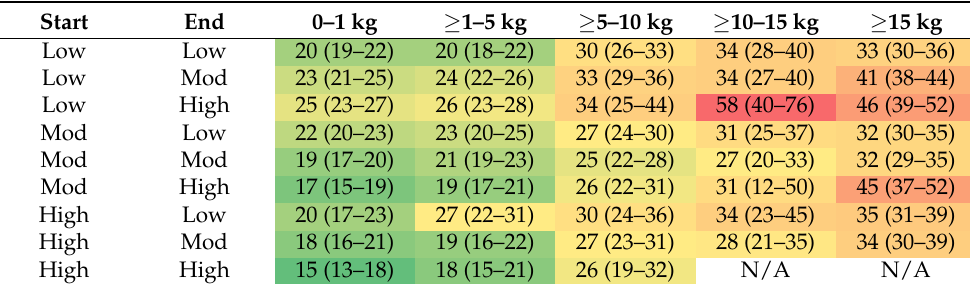
Muscular workload estimates color graded from green to red, with lower estimates marked as nuances of green and higher estimates marked as nuances of red. The analyses were mutually controlled for each predictive variable, participant age, sex, and muscle. Table 4. Muscular workload of the lower back arranged by load mass and start and end position of the lift. The interaction between start and end position for muscular workload was statistically significant. Estimates are presented as % nEMG (95% CI).